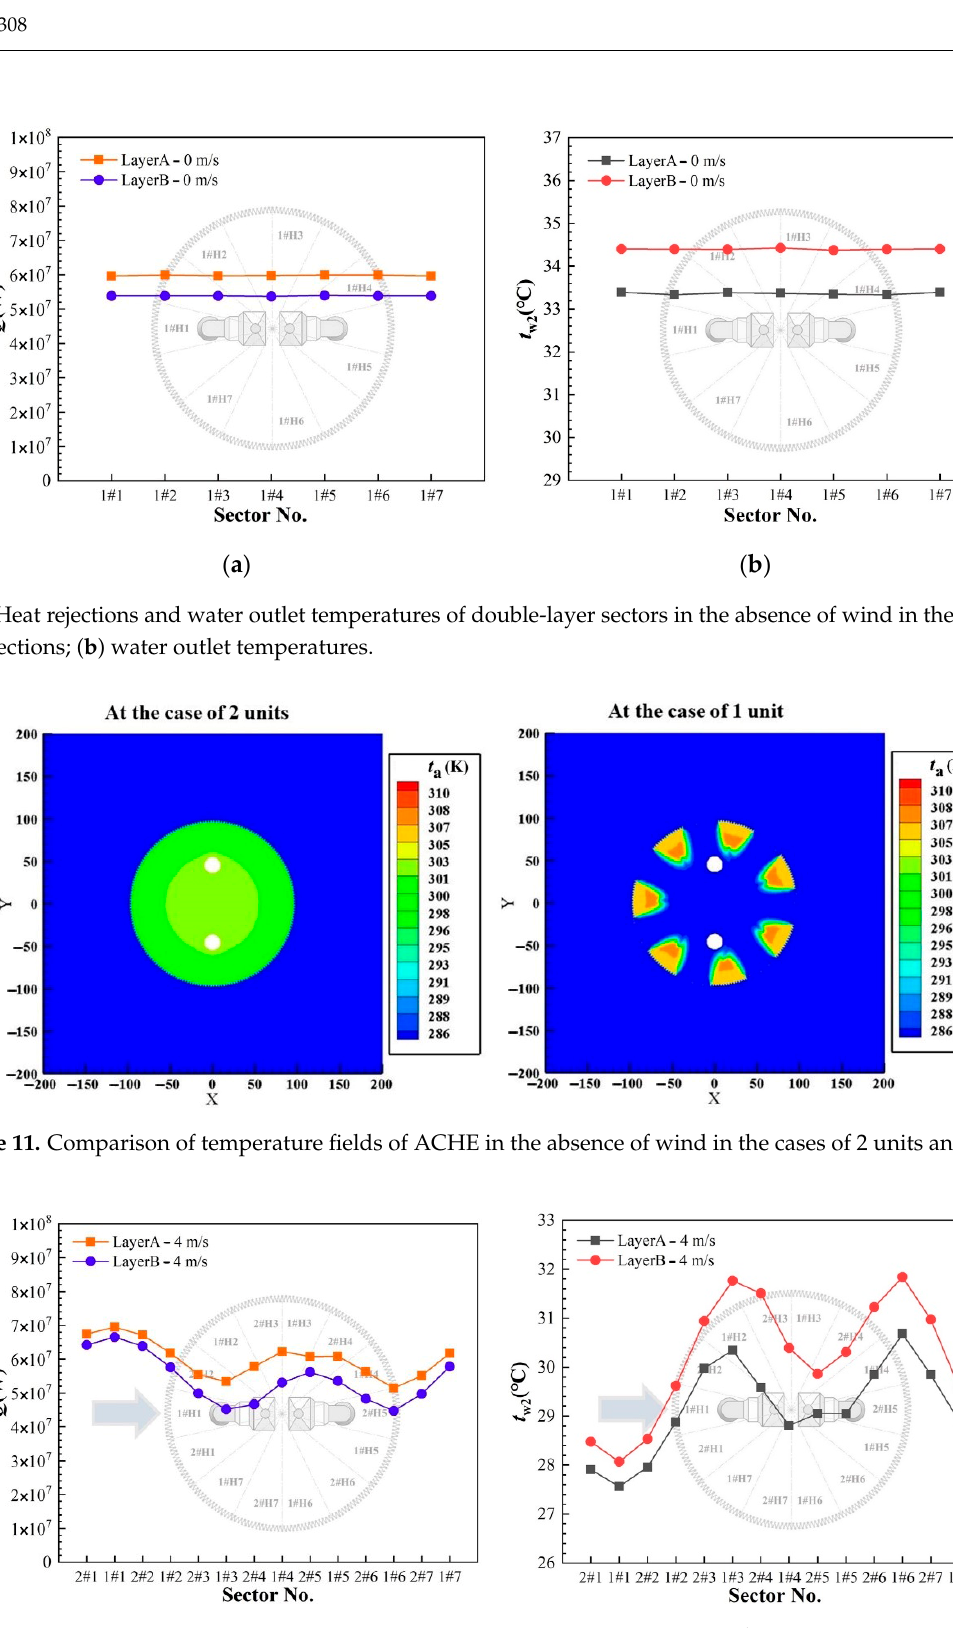
Figure 12. Heat rejections and water outlet temperatures of double-layer sectors under a typical crosswind of 4 m/s in the case of 2 units. ( a ) Heat rejections; ( b ) water outlet temperatures.